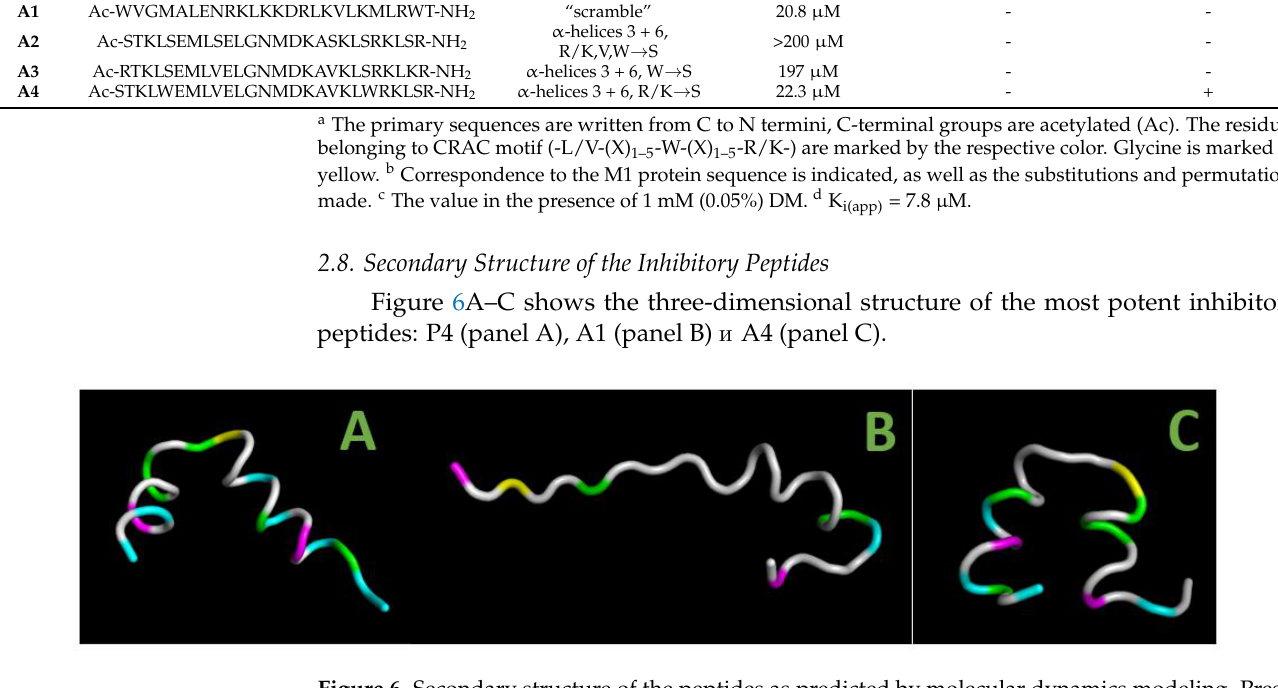
Figure 6. Secondary structure of the peptides as predicted by molecular dynamics modeling. Preset parameters: 50 mM NaCl, T = 300 K, p = 1 bar, temperature control according to Berendsen [53]. The shown dynamic structure corresponds to the 100th ns of the molecular dynamic simulation. The residues belonging to the CRAC motif and Gly are marked in color as in Table 1. ( A – C ) The peptides P4, A1, and A4, respectively.